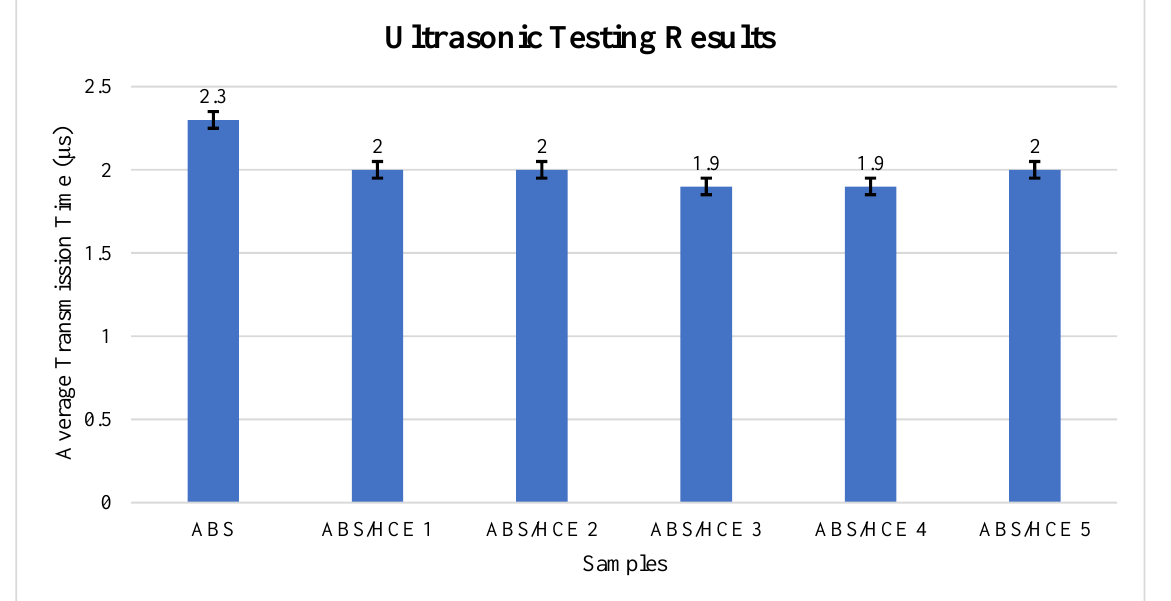
Figure 7. Ultrasonic testing results of ABS/HCE composites with ABS. The GEP concoction was obtained by mixing HCE with three different weight per- centages (0.2 wt.%, 0.4 wt.%, and 0.6 wt.%) of GNPs. The mixtures were ultrasonically processed to obtain a uniform homogeneous mixture, which improves the bonding between the polymer layer and the TA materials. The ultrasonic results for ABS/GEP composites with ABS are shown in Figure 8.